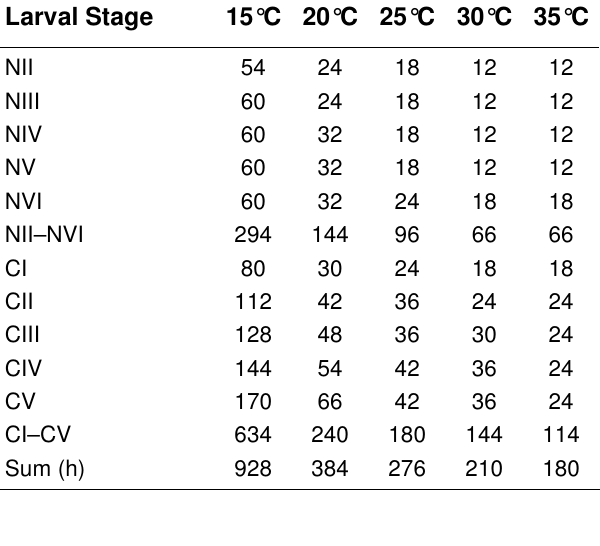
Development Time (h) of Larvae of P. dubia under